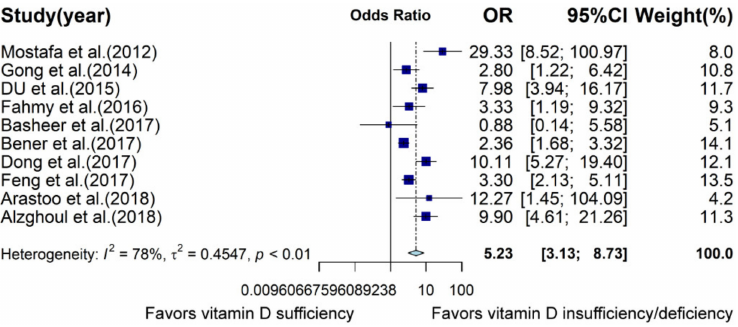
Figure 3. Forest plot of meta-analysis of 10 case–control studies based on odds ratio (OR), demon- strating that children with vitamin D insufficiency and deficiency are about 5.23 times more likely to develop ASD than vitamin D sufficient children are, with 78% heterogeneity. CI, confidence